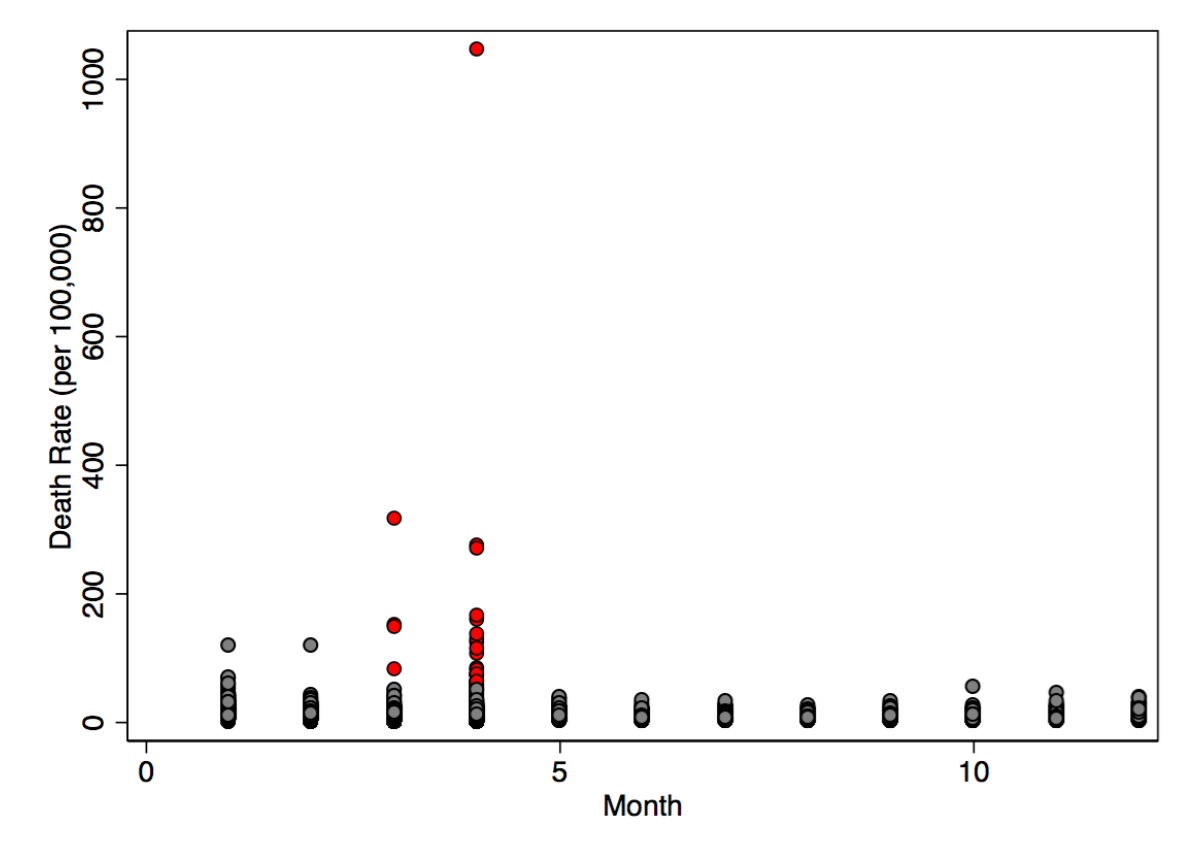
Figure A8. COVID-19 (2020) and total respiratory deaths (2018). Notes: Red indicates deaths due to COVID, black indicates all respiratory deaths. Each dot represents the deaths in a county for a given month. Source